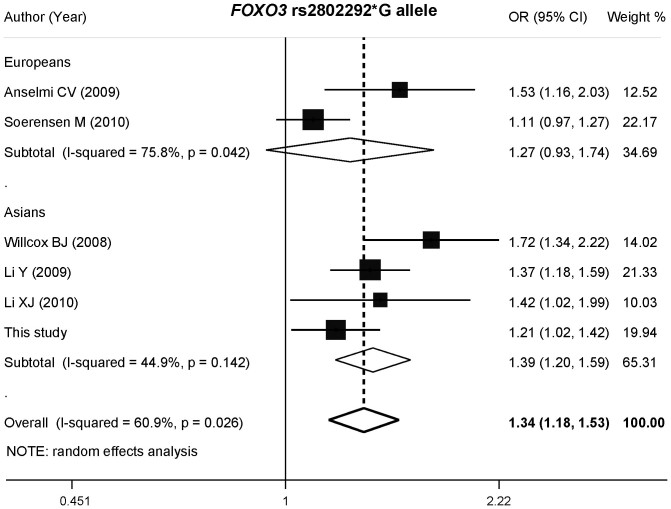
Forest plot (allele-contrast model) of the association between rs2802292*G allele and longevity stratified by ethnicities.For each study, the estimate of OR and its 95% CI is plotted with a box and a horizontal line.